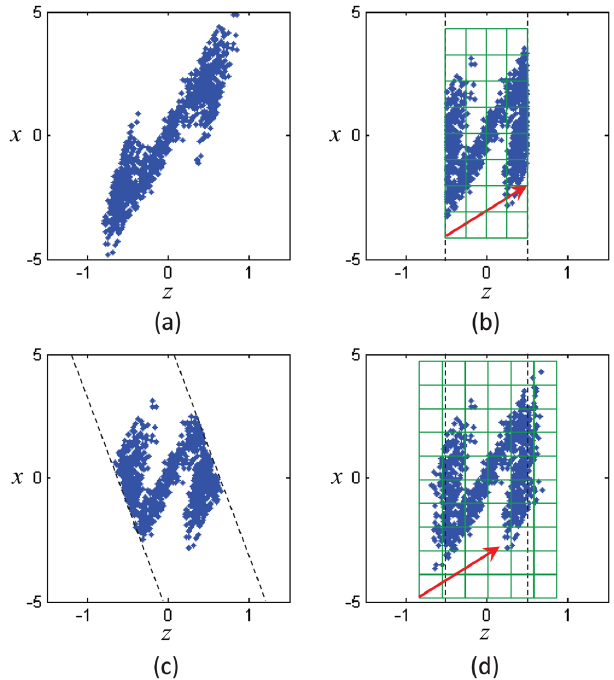
FIG. 6. Equivalent generating sets S distribution: (a) volume is not limited to a one-period-slice; (b) particles in one-period-slice and mesh that supports perio- dicity; (c) particles in equivalent one-period-slice; (d) particles without sharp truncation and mesh that does not support